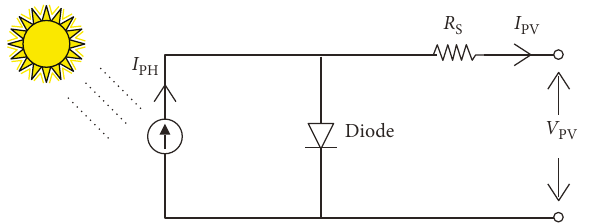
Figure 2: Equivalent circuit model of a PV solar